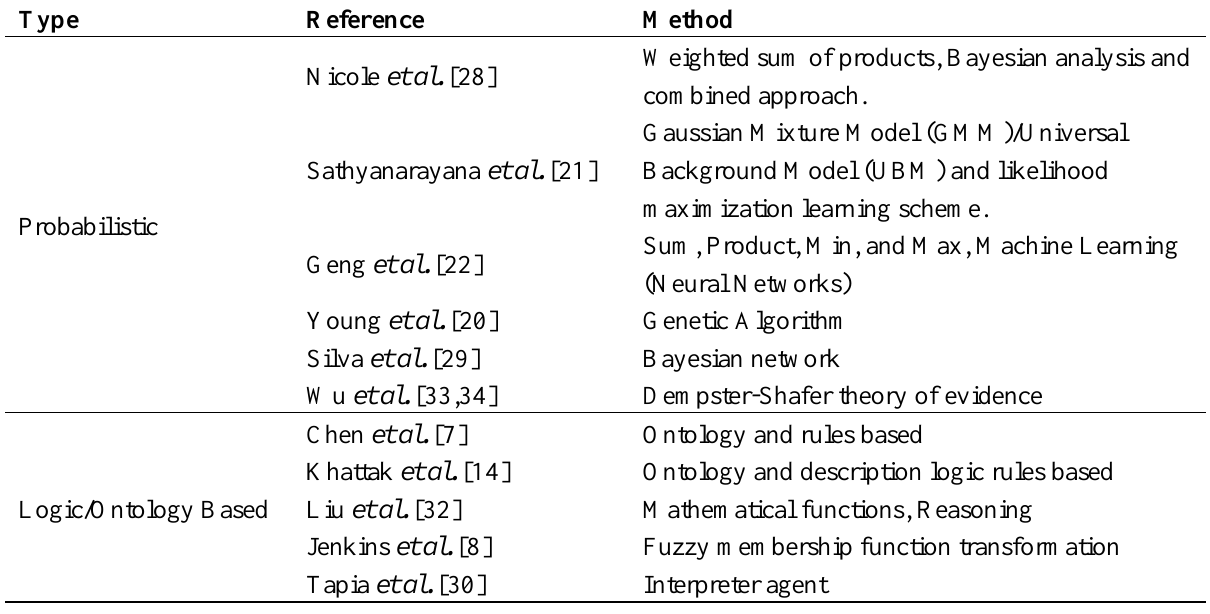
Table 3. Existing systems and the context fusion scheme used by these